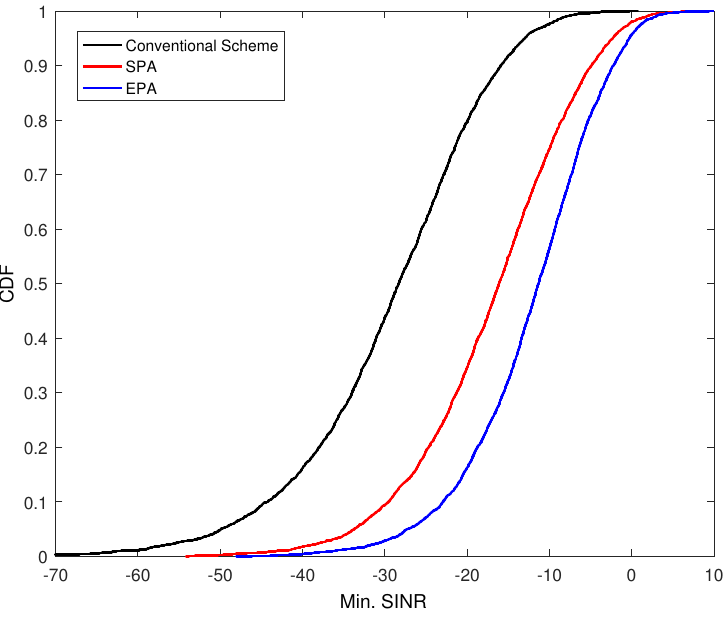
Figure 6. The CDF of the min. SINR when M = 64 using